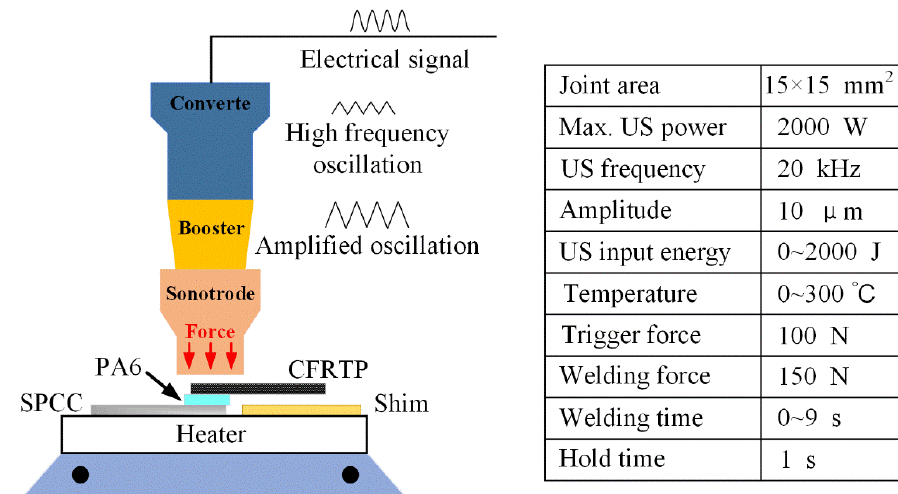
Figure 4. Schematic diagram of the ultrasonic plastic welding system.